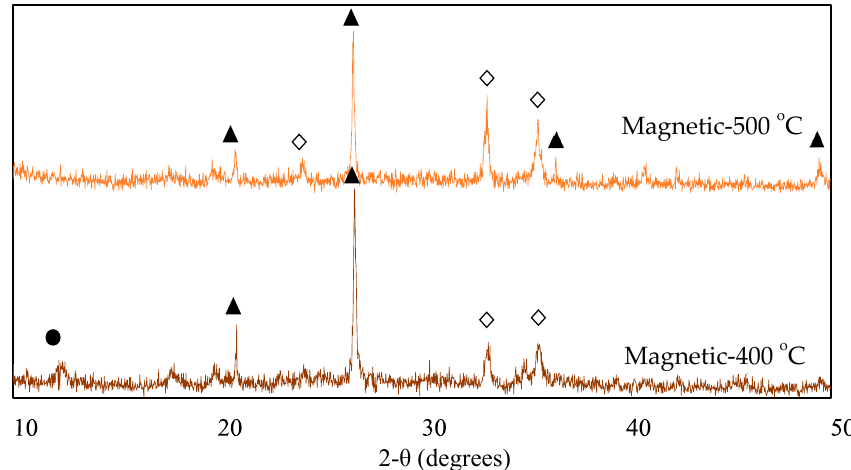
Figure 7. XRD analysis of the magnetic fraction of the 2.20 SG sink fraction of Baker seam coal calcined at 400 ◦ C and 500 ◦ C ( -Kaolinite; -Quartz; -Hematite).